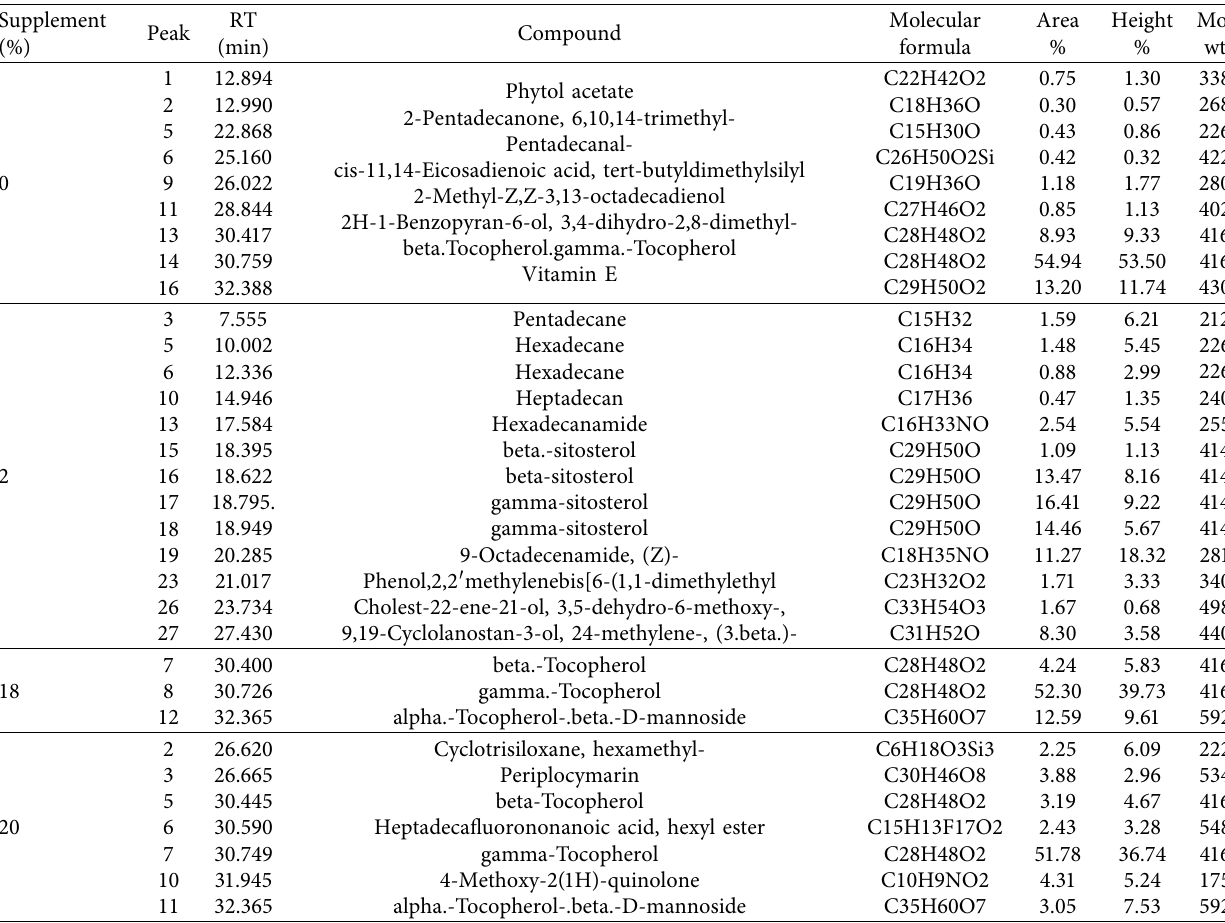
Table 3: GCMS profiling of methanolic extracts of P . ostreatus mushroom grown from sugarcane substrates supplemented with varying levels of wheat bran.